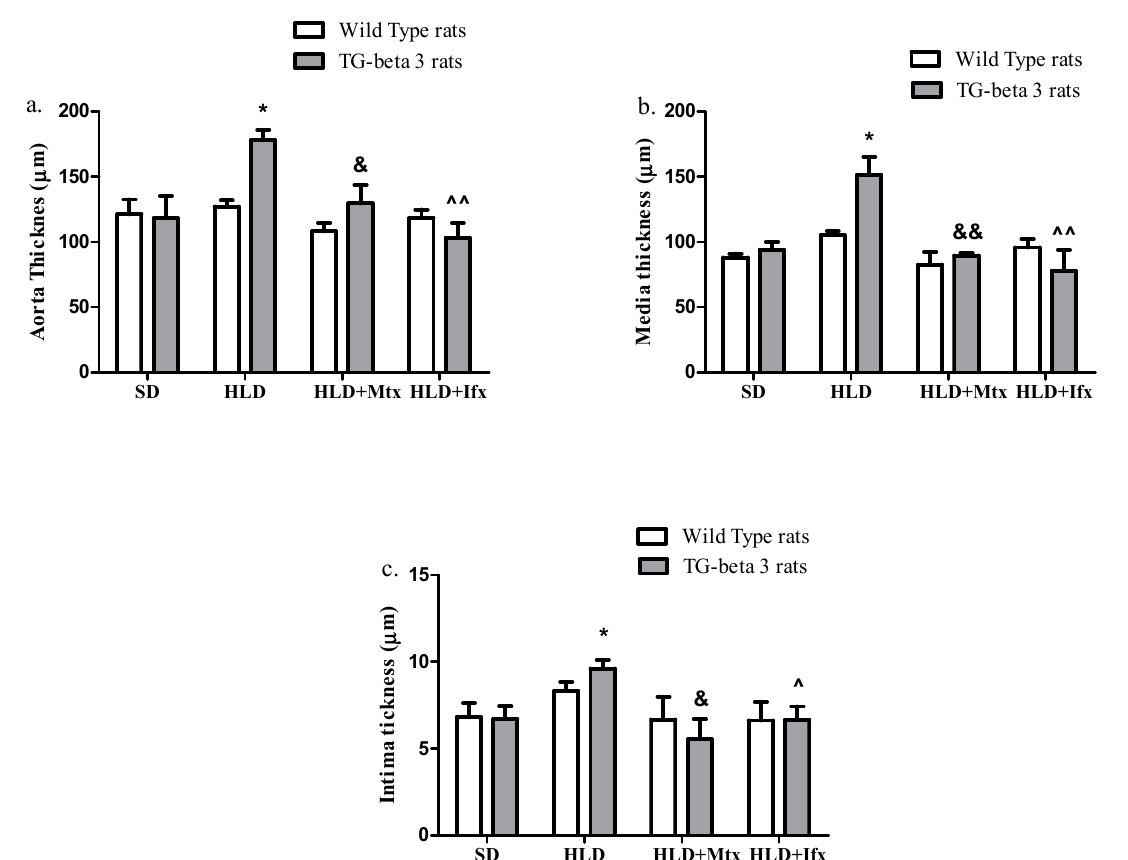
Figure 8. Methotrexate and infliximab effects on aortic histopathological sections. ( a ) Aorta thickness; ( b ) media thickness; ( c ) intima thickness. SD—standard diet; HLD—high lipid diet; Mtx-methotrexate; Ifx-infliximab; HLD + Mtx—high lipid diet associated with methotrexate; HLD + Ifx—high lipid diet associated with infliximab. * p < 0.05; HLD versus SD group; & p < 0.05; && p < 0.01; HLD + Mtx versus SD group; ^ p < 0.05; ^^ p < 0.01; HLD + Ifx versus SD group.